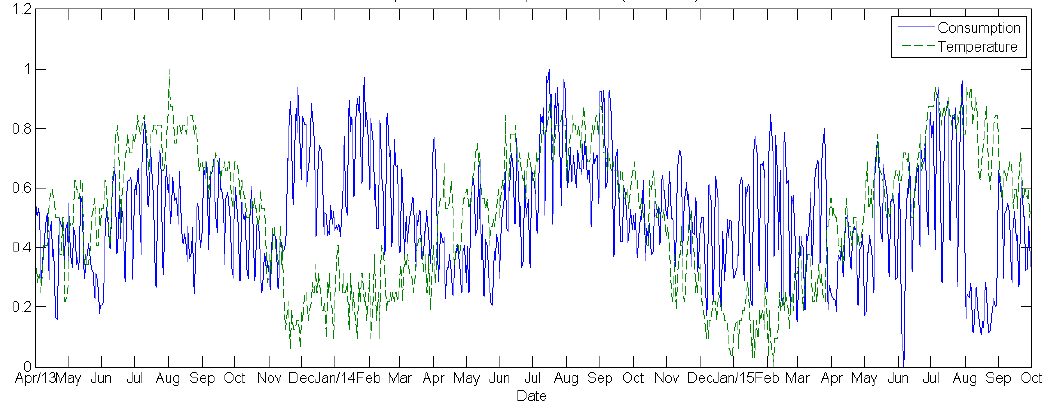
Figure 7. Sample of control ventilation system.